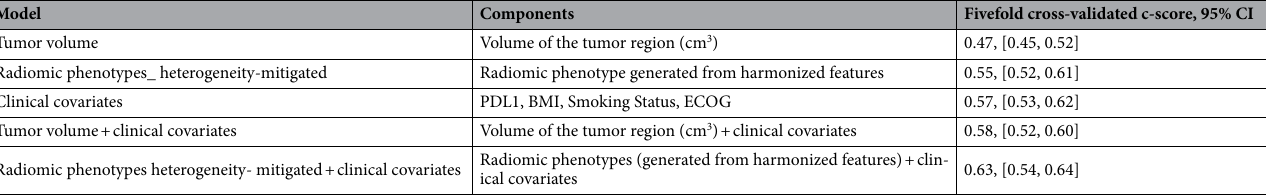
Table 5. Progression-free survival Cox proportional-hazards regression analysis c-scores.